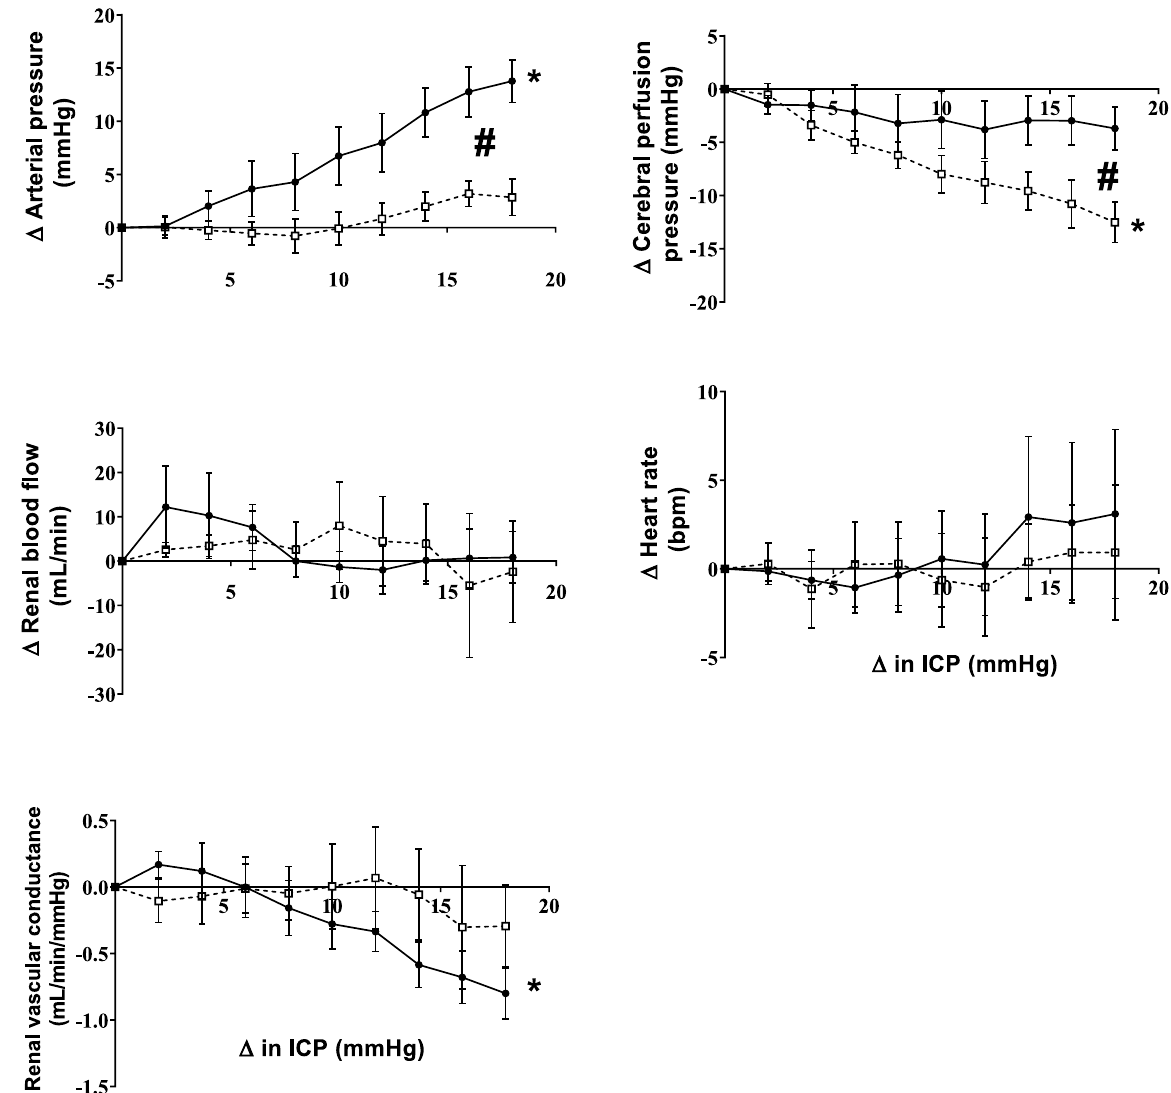
Figure 5. Response of arterial pressure, cerebral perfusion pressure, heart rate, renal blood flow and renal conductance to increased ICP in control sheep before (closed circles, n = 6) and after ganglionic blockade with hexamethonium (open circles, n = 6). Data are mean ± SE and are plotted as change from baseline. *denotes significant effect of ICP change while # denotes significant interactions effect (group vs. ICP change); p <